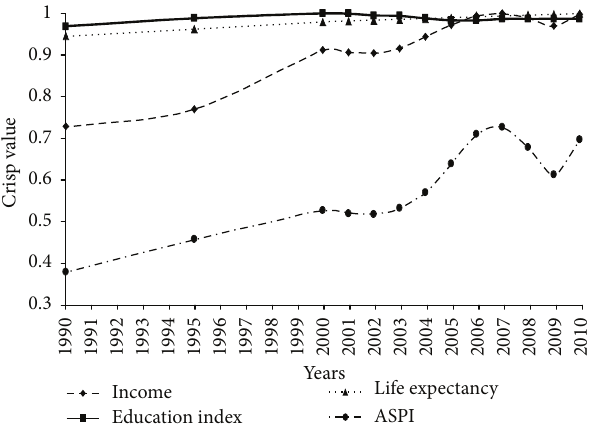
Figure 3: Historical Trend of Activity System Performance Index and its Performance Measures.